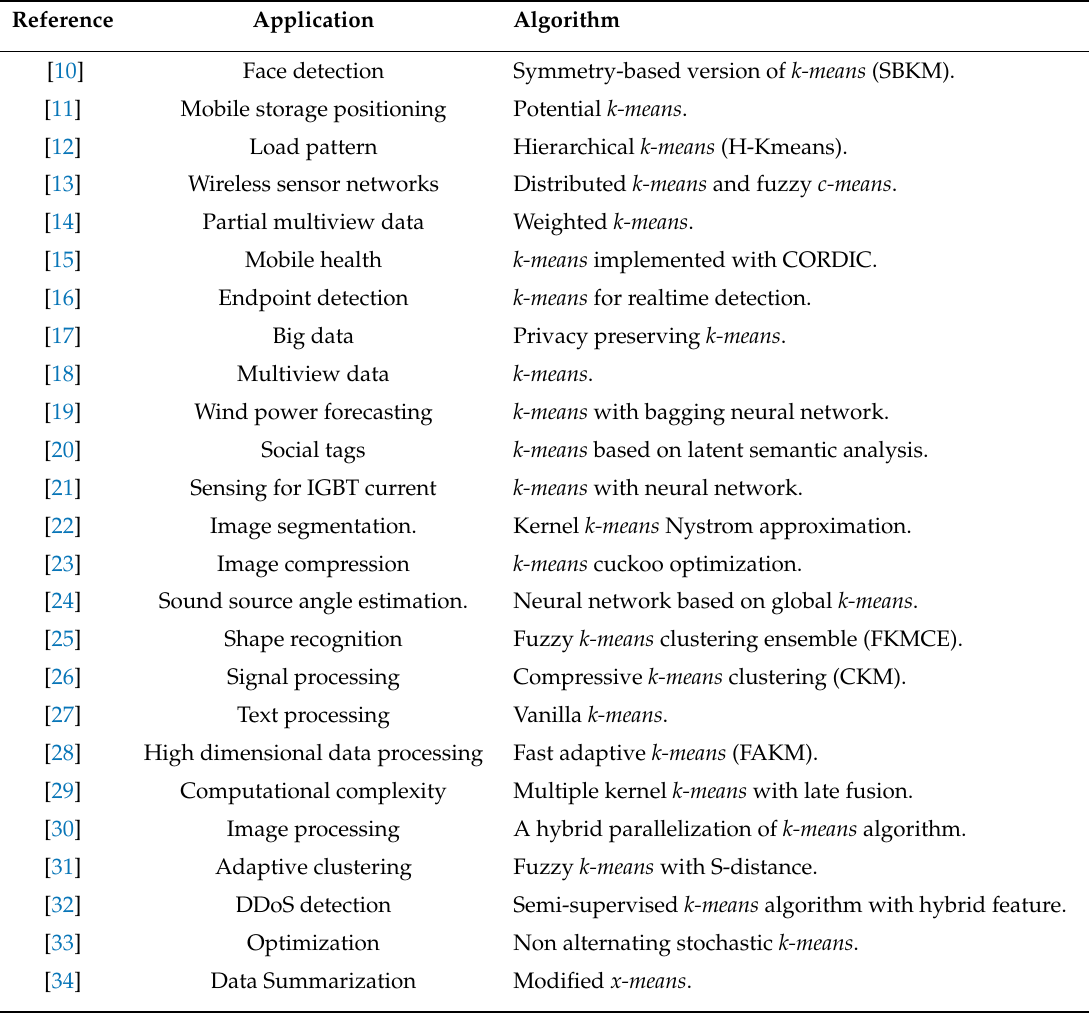
Table 1. Applications of variants of the k-means algorithm in different application domains. Reference Application